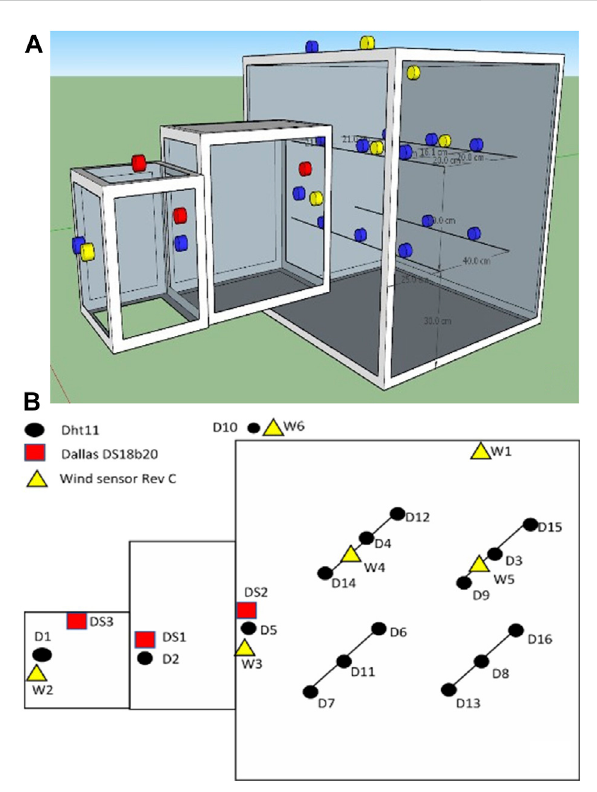
FIGURE 2 Sensor ’ s location and placement with (A) 3D view of the location ofthesensorinthemeasurementchambersand (B) corresponding2D view in the proposed WIEC passive system.